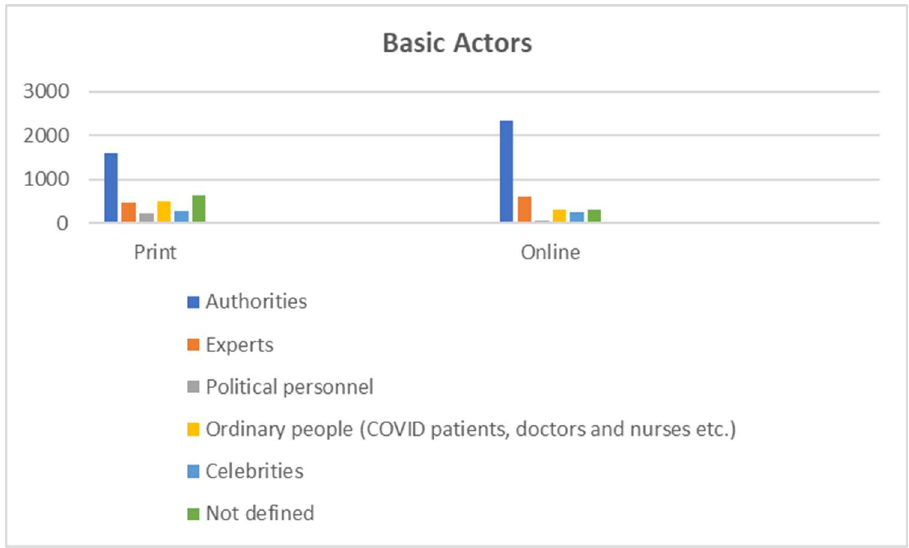
Figure 5. Basic actors.